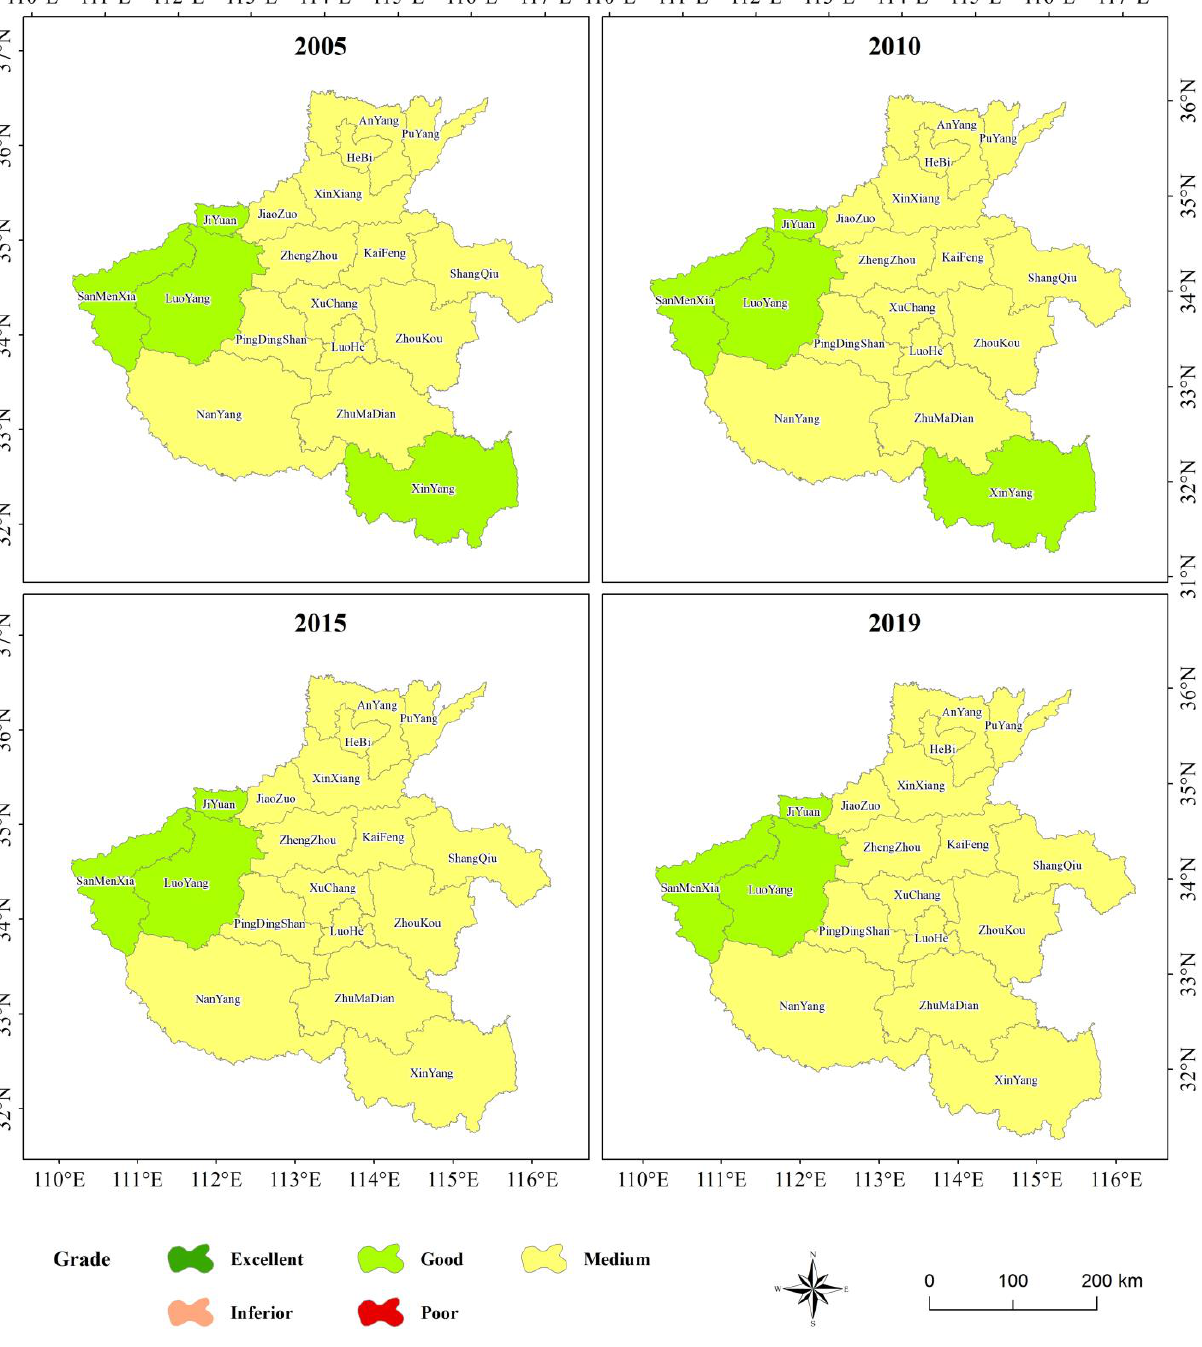
Figure 4. Eco-environmental quality level of the Henan Province using EI model